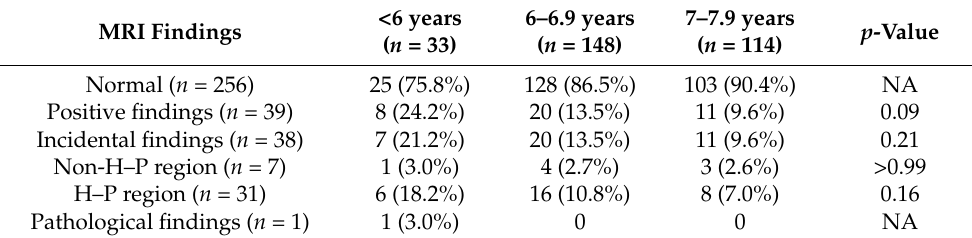
Table 3. Brain MRI findings based on age at pubertal onset in girls with